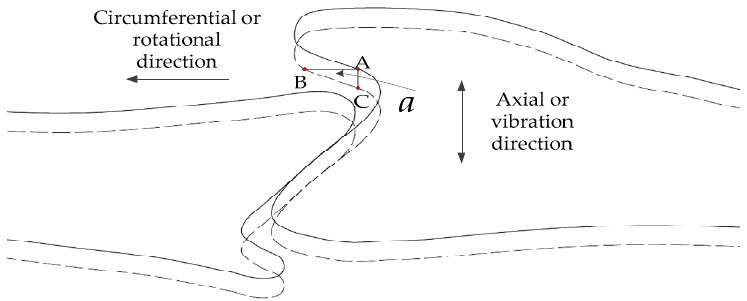
Figure 2. The interlocked shroud structure of a steam turbine.